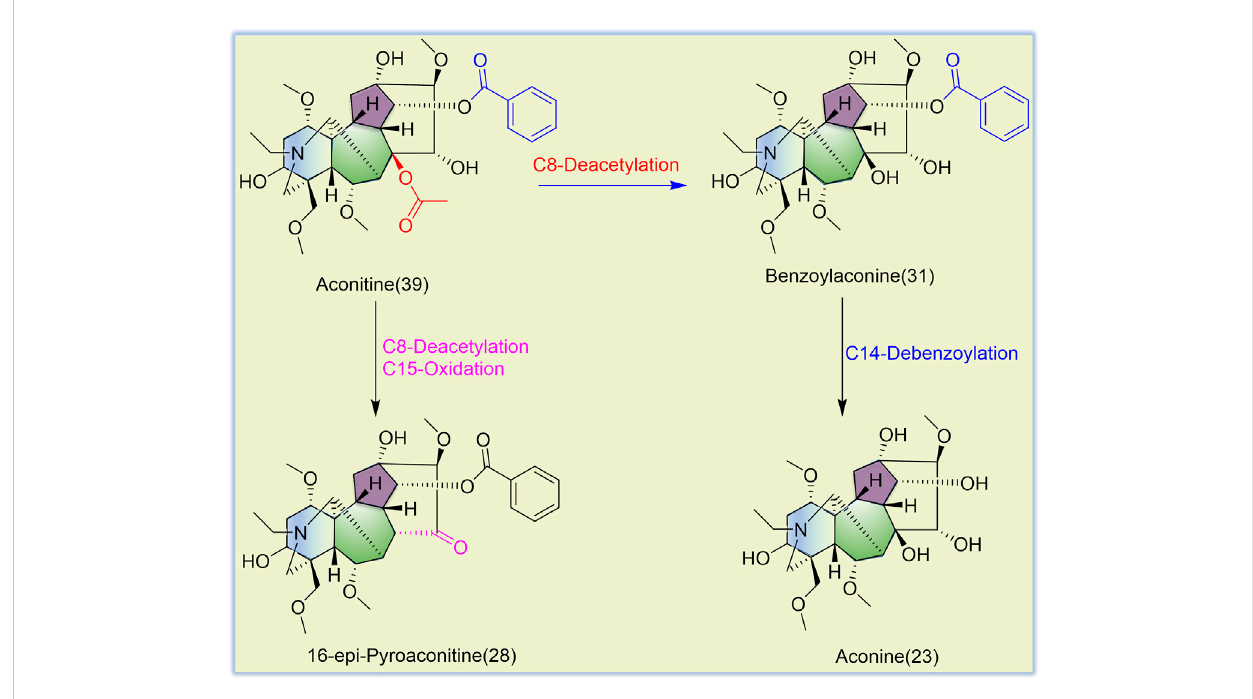
FIGURE 7 Possible mechanism of alkaloids transformation in the process of